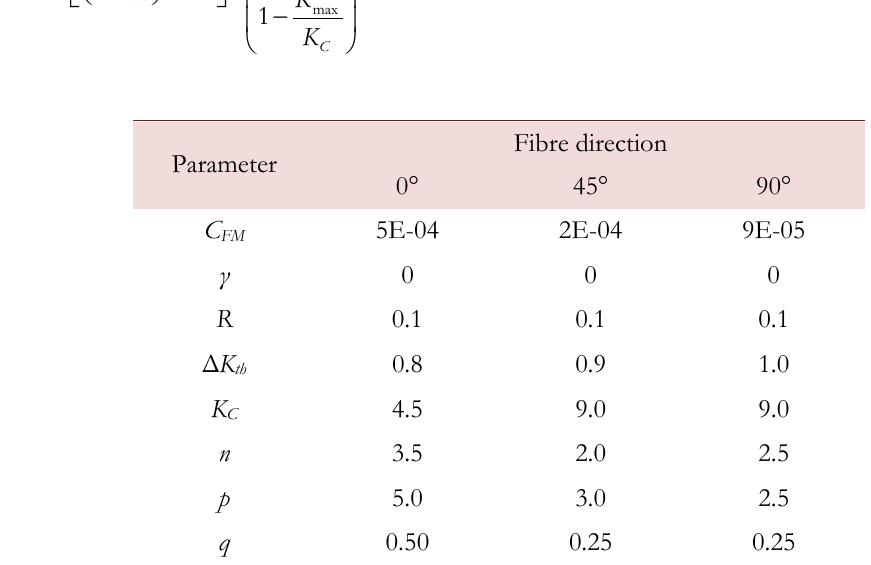
Table 2: Forman/Mettu equation